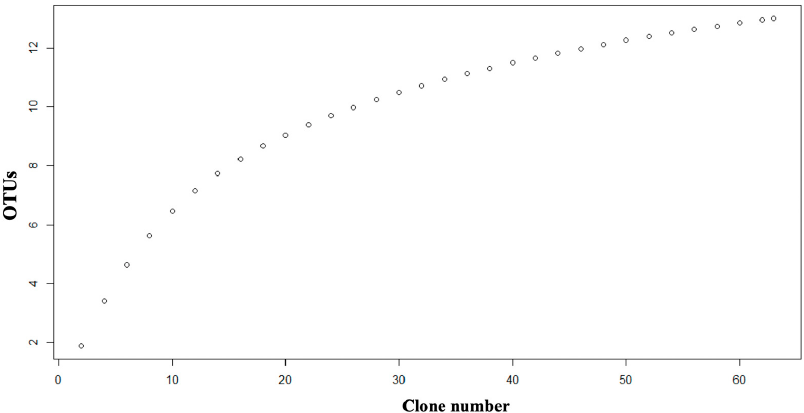
Figure A1. Phylogenetic network showing the clustering of obtained arbuscular mycorrhizal fungal sequences through a monophyletic clade approach into 13 operational taxonomic units (OTUs).